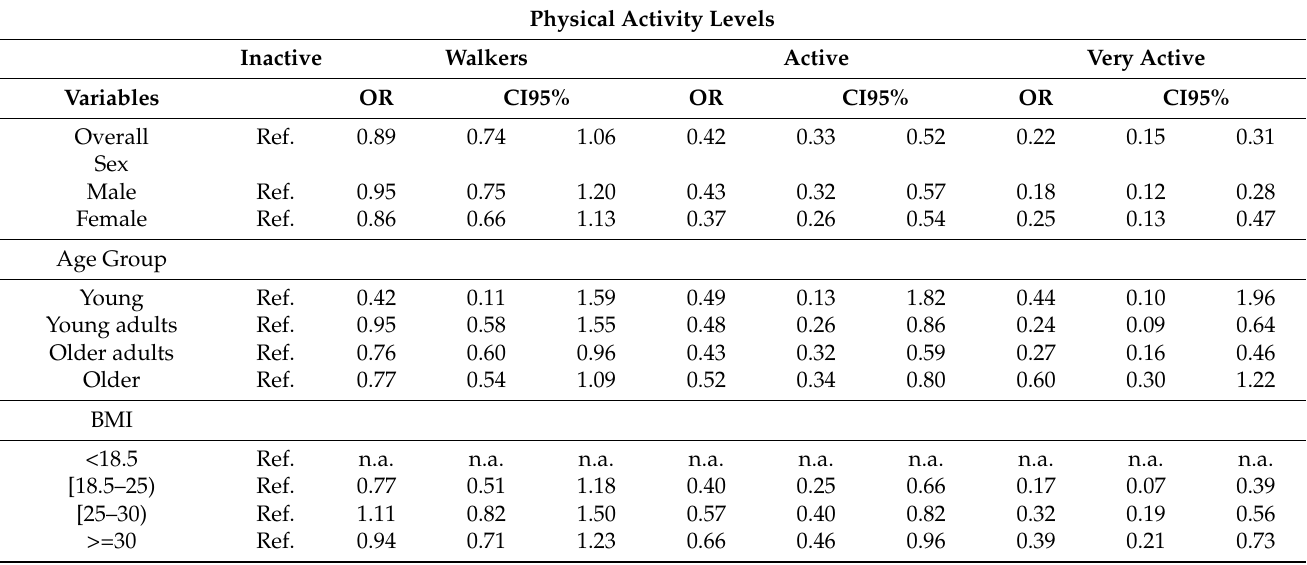
Table 6. Diabetes Medication Use Risk according to the Physical Activity Level.